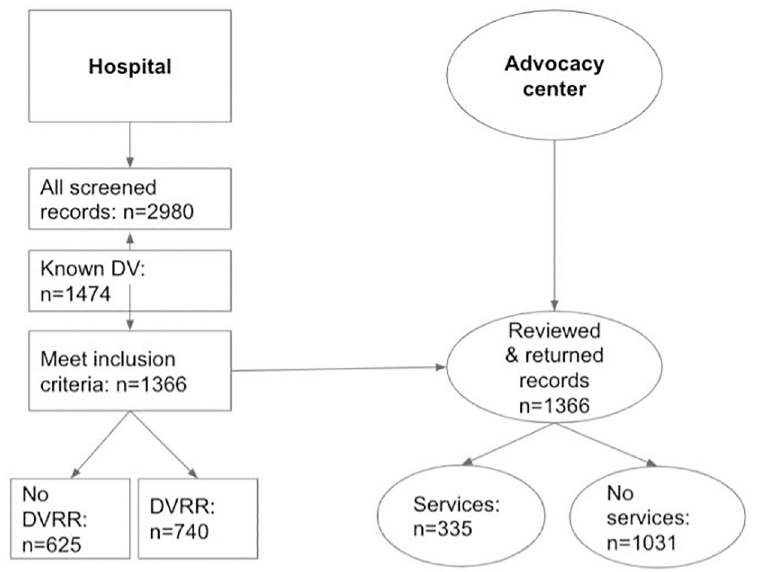
Fig 1. Selection flow of medical and advocacy records included for